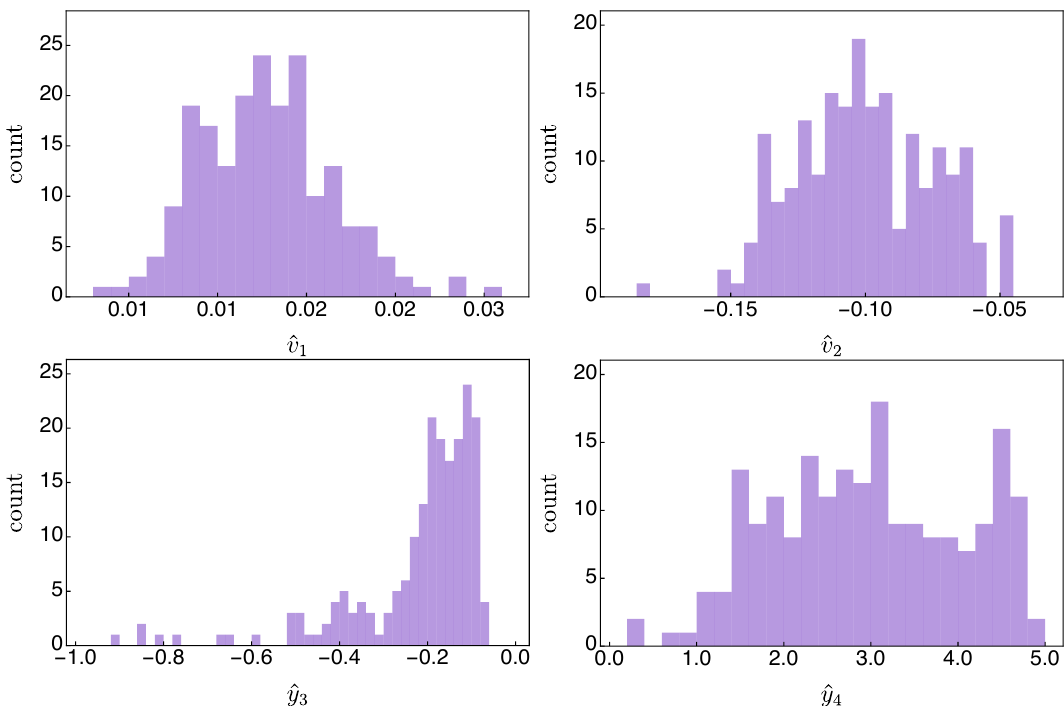
Figure 22. Histograms of the distribution of the four low-energy constants appearing in the EFT of section 6.1 at the next-to-the-leading order, as determined from the global (cid:12)t.